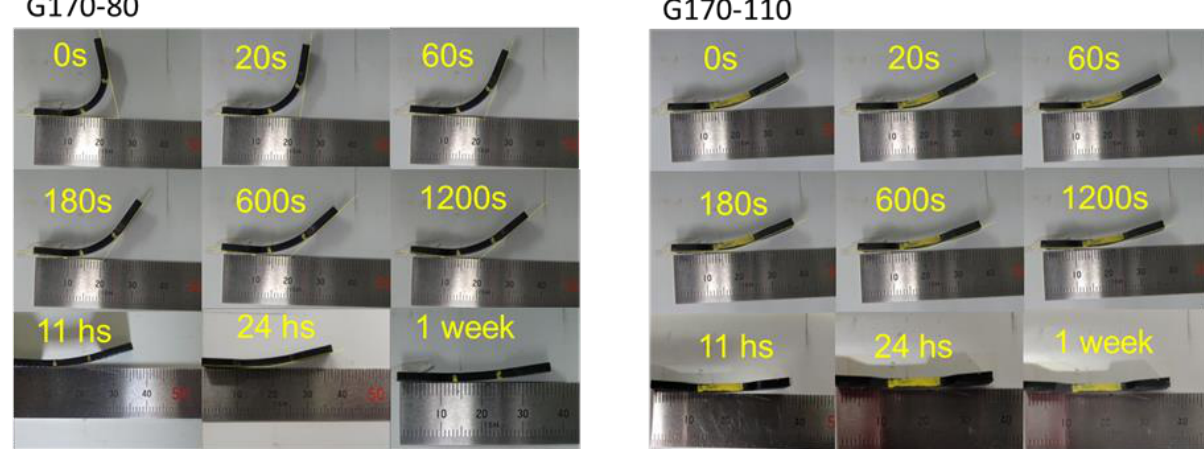
Figure 6. Recovery process after stress removal.